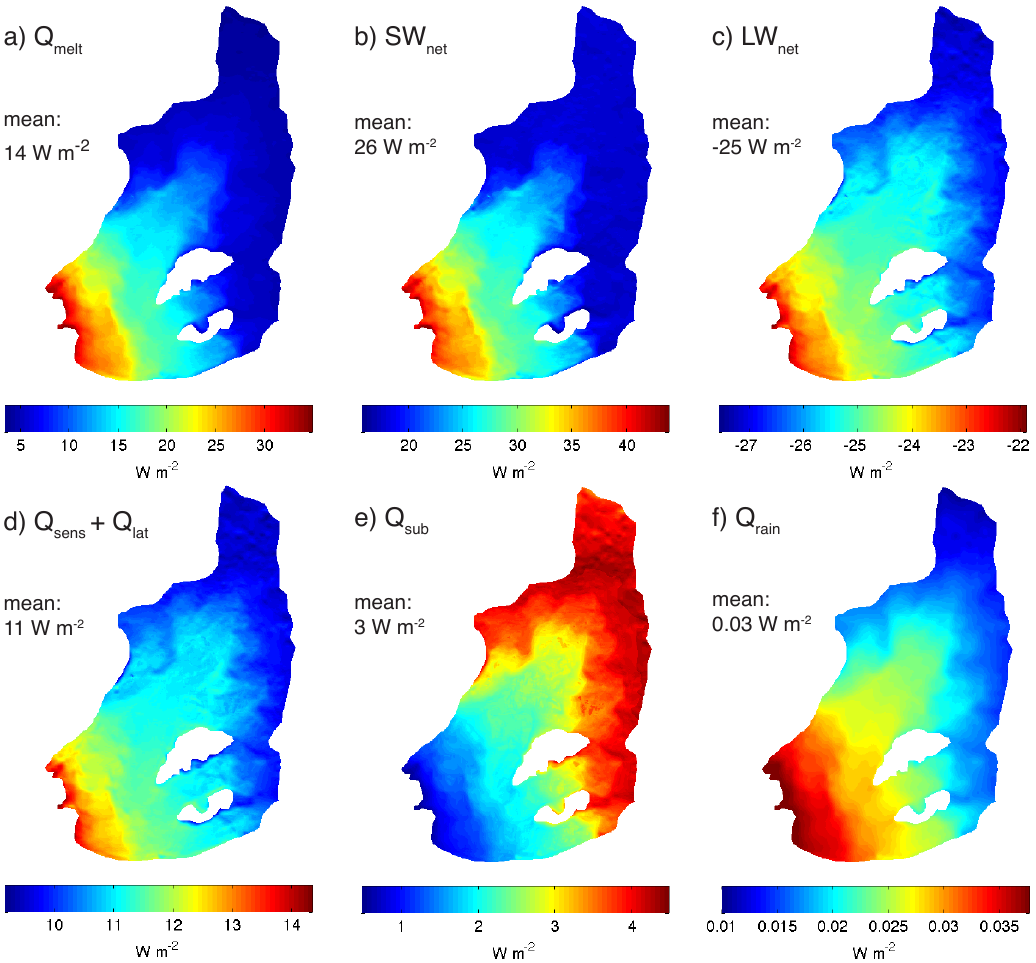
Fig. 6. Contour plots of the melt energy (a) , net shortwave radiation (b) , net longwave radiation (c) , turbulent heat transport (d) , the subsurface heat flux (e) and the heat supplied by rain (f) , averaged over the period 1989–2010.